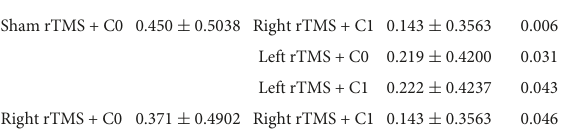
TABLE 2 One-way ANOVA models for relapse rate between the six groups.